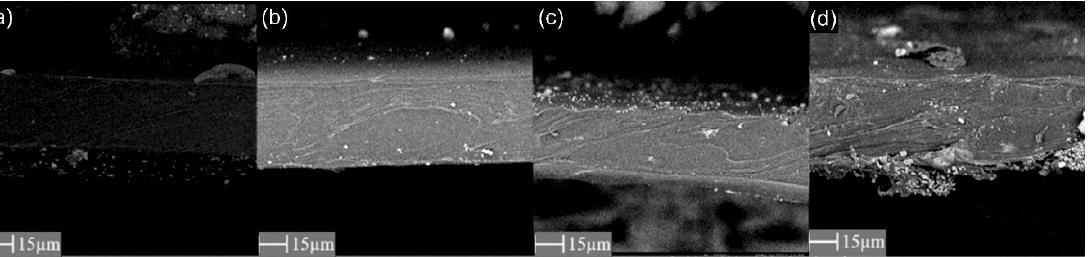
Figure 5. SEM image of membrane cross section with SiO 2 added; ( a ) PEBAX 2533 + 0 wt% SiO 2 , ( b ) PEBAX 2533 + 2 wt% SiO 2 , ( c ) PEBAX 2533 + 5 wt% SiO 2 , ( d ) PEBAX 2533 + 10 wt% SiO 2 .